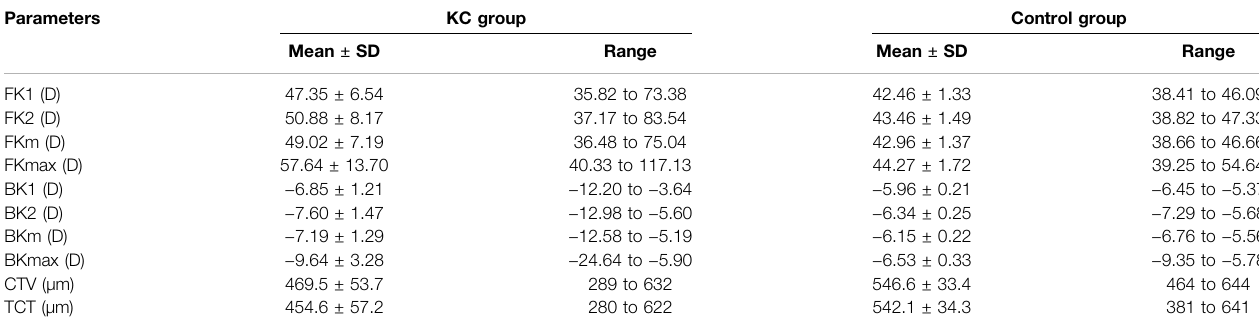
TABLE 1 | Mean values of main topographic parameters. Parameters